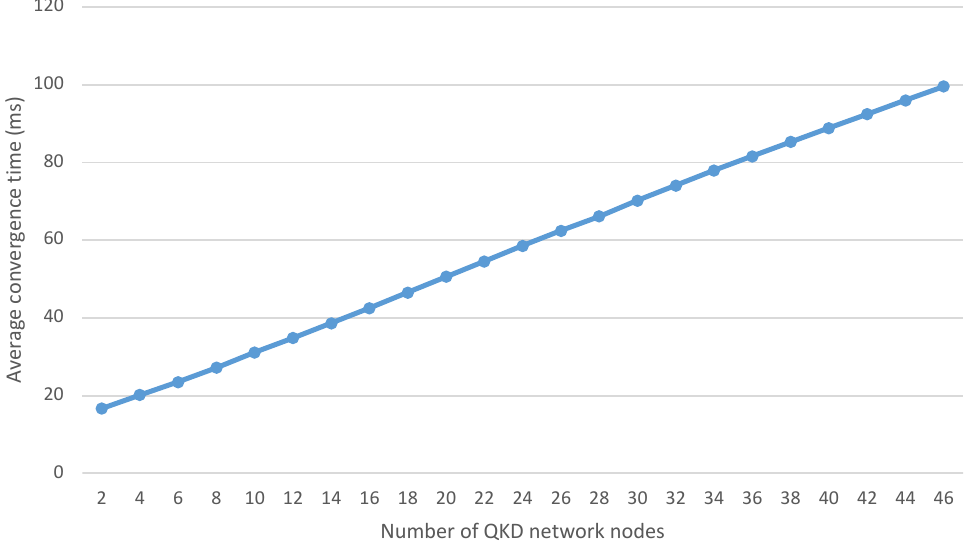
Figure 11. Average convergence time of the routing algorithm depending on the number of nodes in the QKD